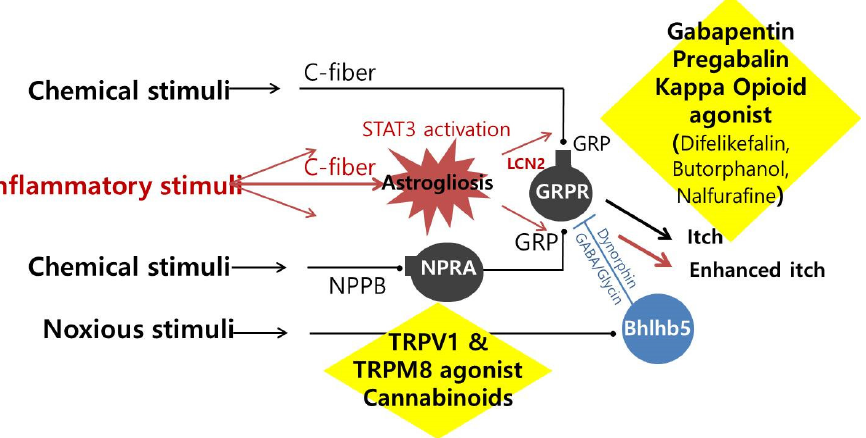
Figure 2. The mechanism of treatment for patients with uremic pruritus STAT3; Signal transducer and activator of transcription 3, GRP; Gastrin-releasing peptide, GRPR; Gastrin-releasing peptide receptor, LCN2; Lipocalin-2, NPRA; Natriuretic peptide receptor-A, NPPB; Natiurtetic polypeptide b, GABA; Gamma-aminobutyric acid, Bhlhb5; Basic helix-loop-helix B 5, TRPV1; Transient receptor potential vanilloid type 1, TRPM8; Transient receptor potential melastatin 8